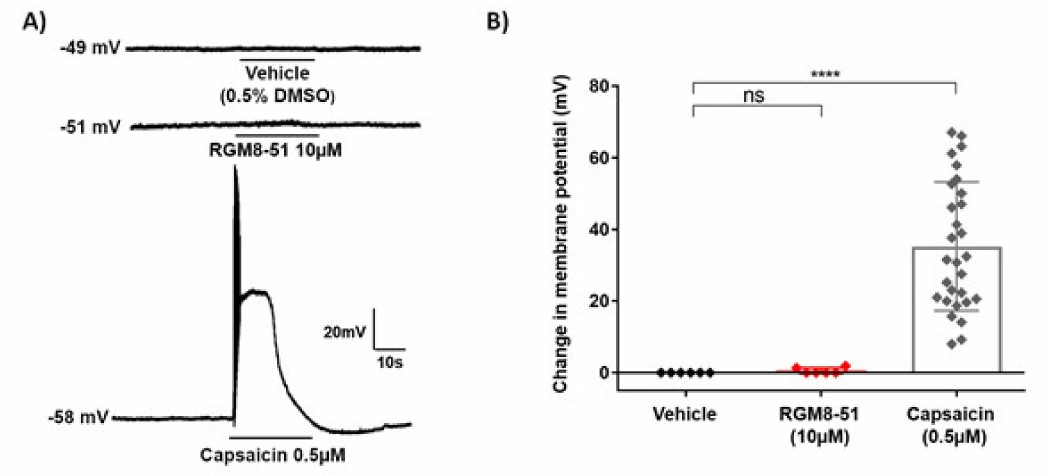
Figure 4. Compound RGM8-51 does not affect the membrane resting potential of sensory neurons. ( A ) Representative recordings of resting membrane potential measured under current-clamp conditions. The upper trace shows how the resting membrane potential remains constant after the addition of vehicle, and 10 µ M of compound RGM8-51 (middle trace). The bottom trace shows action potentials firing in a DRG neuron exposed to 0.5 µ M capsaicin. ( B ) Changes in membrane potential in the absence and the presence of 10 µ M of compound RGM8-51, and in the presence of capsaicin (Cap) 0.5 µ M. Data were analyzed by one-way ANOVA followed by Bonferroni post hoc test for multiple comparisons (ns = no significance, **** = 0.0001) and given as mean ± SEM; n ≥ 6 cells from 2